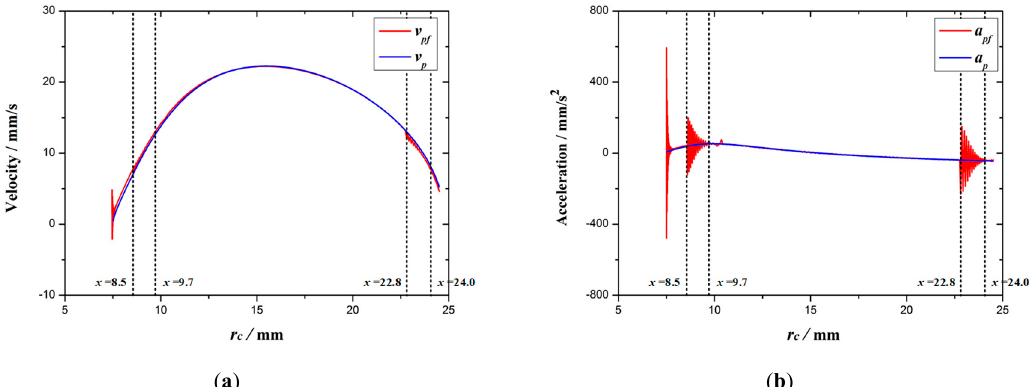
Figure 13. The response curves of velocity ( a ) and acceleration ( b ). Table 3. Maximum amplitude of velocity and acceleration with different expanding radius.